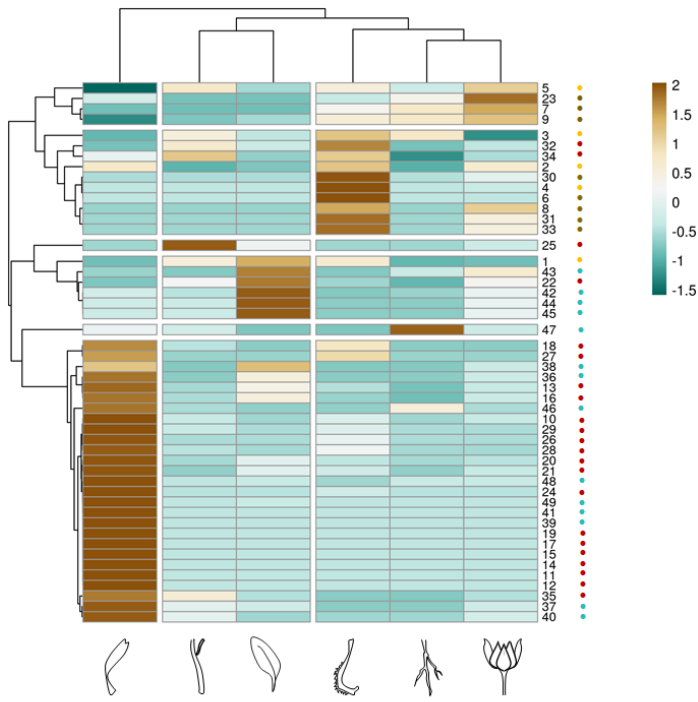
Figure 3. PCA of tentatively identified metabolites in six organs of Calendula arvensis.